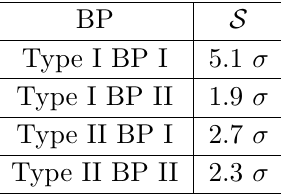
Table 4 . Signal signi(cid:12)cance for the benchmark points at 14 TeV with L = 3000 fb (cid:0) 1 in the gluon fusion